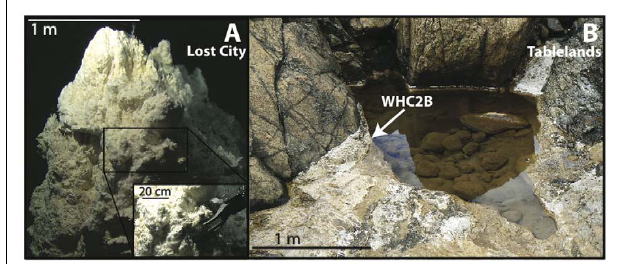
FIGURE 1 | Photographs of the Lost City (A) andTablelands (B) sites where metagenome samples were collected. The Lost City metagenome sample was grabbed by the manipulator on the ROV Hercules, comprising approximately 1kg of carbonate minerals and associated biofilm material (A inset) from the Poseidon pinnacle (A) at the Lost City hydrothermal field. TheWHC2b metagenome sample was collected by filtering 10L of fluid from a pH 12 pool approximately 2.5m long, 1m wide, and less than 1m deep (B) . Fluid was collected by gentle suction from a depression in the bottom of the pool underneath a ledge [arrow in (B) ], which appeared to be a source of the spring fluid.Travertine (carbonate) deposits are visible around the edge of the pool. Lost City photo credit: Deborah Kelley, U. of Washington, IFE, URI–IAO,